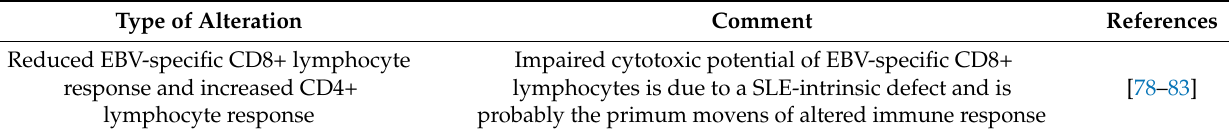
Table 4. Peculiar alterations of EBV-specific immune response in